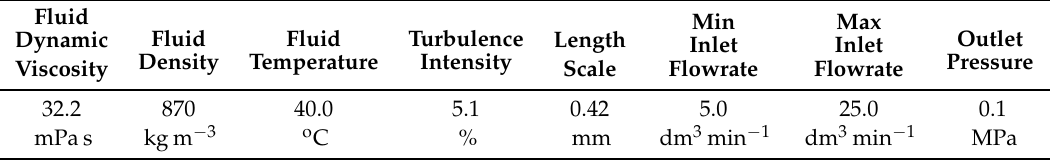
Table 2. Physical parameters and boundary